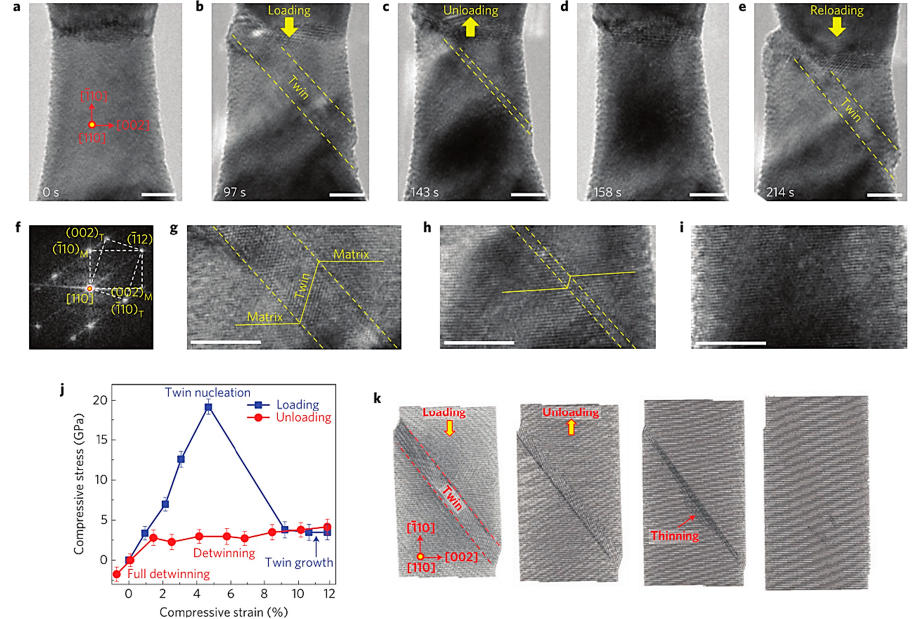
Figure 3. Reversible deformation twinning and detwinning processes in a W bicrystal nanowire